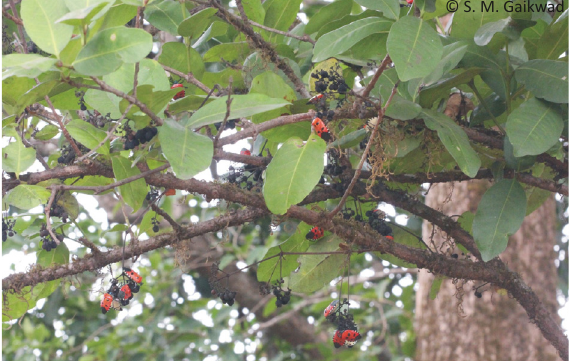
Image 1. Aggregation of Catacanthus incarnatus - adults on I. brachiata